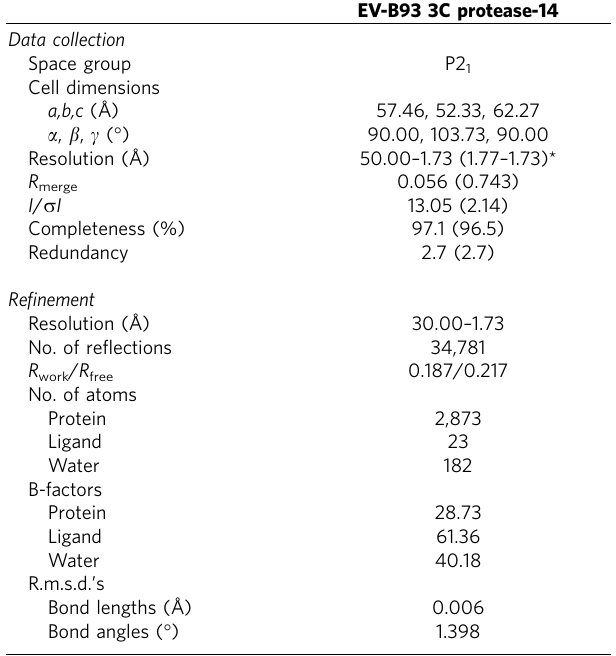
Table 4 | Data collection and refinement statistics for the complex of EV-B93 3C protease with inhibitor 14 (PDB: